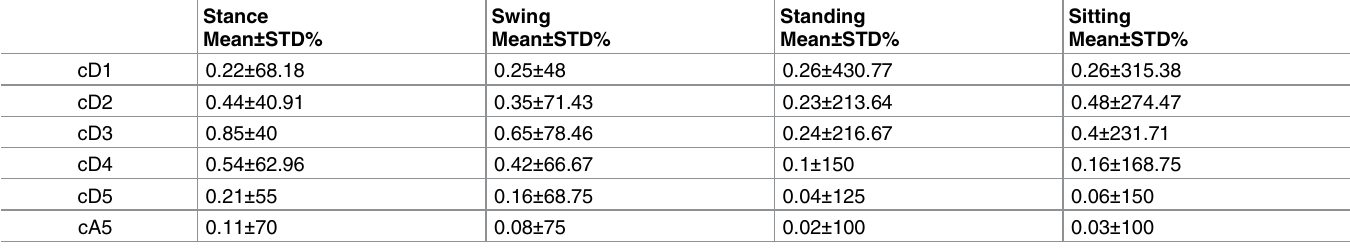
Table 3. The mean and STD results of time-frequency featuresby WT-based SVD approach based on experimental trails from all participants on the vastus medialis muscle.